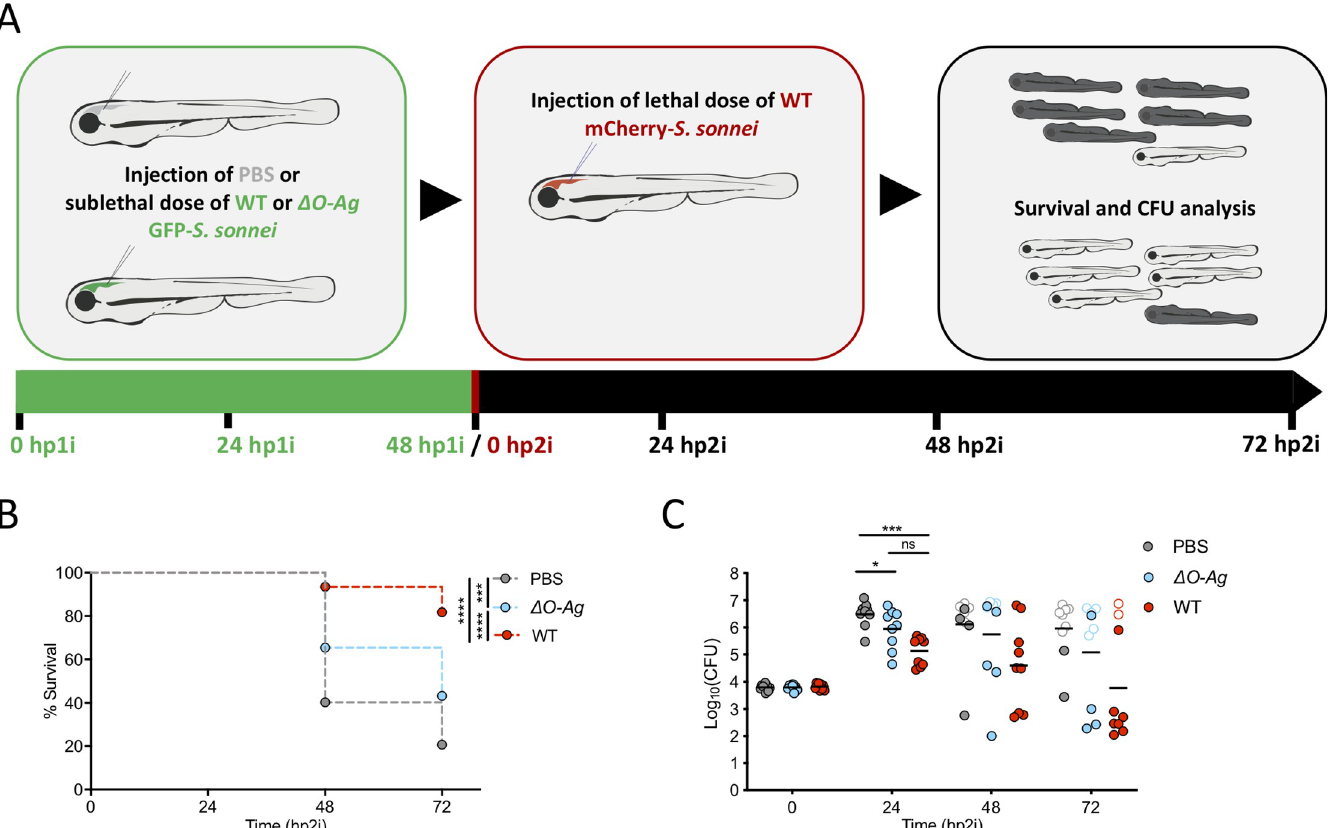
Fig 7. Innate immunity can be trained to control S . sonnei in vivo . A. Model for S . sonnei reinfection . 2 dpf embryos were primed with PBS or a sublethal dose of S . sonnei . At 48 hours post primary infection (hp1i), larvae where challenged with a lethal dose of S . sonnei and monitored by survival assay for 72 hours post-secondary infection (hp2i). B,C. Innate immune training to S . sonnei is dependent on O-antigen. Survival curves (B) and Log 10 -transformed CFU counts (C) of 4 dpf larvae infected in the HBV with lethal dose (~8000 CFU) of mCherry-WT S . sonnei . 48 hours prior to infection with lethal dose, embryos were primed by delivering PBS (grey), or a sublethal dose (~80 CFU) of GFP- Δ O-Ag (blue) or GFP-WT (red) S . sonnei . Experiments are cumulative of 4 (B) or 3 (C) biological replicates. In C, full symbols represent live larvae and empty symbols represent larvae that at the plating timepoint had died within the last 16 hours. Statistics: Log-rank (Mantel-Cox) test (B); one-way ANOVA with Sidak’s correction on Log 10 -transformed data (C); ns, non-significant; � p < 0.0332; ��� p < 0.0002; ���� p <